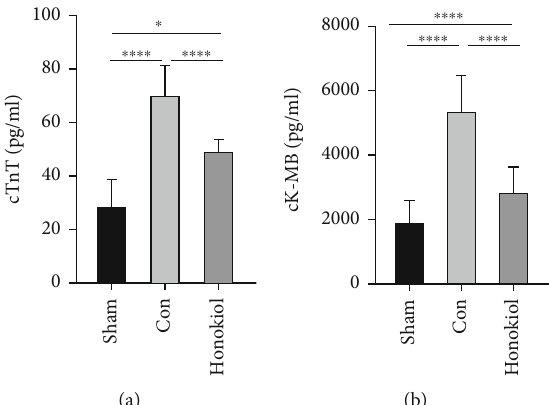
Figure 1: Plasma levels of myocardial injury markers. Expression levels of (a) cTnT and (b) CK-MB. Sham: sham operation; Con: MI/RI with the vehicle; Honokiol: MI/RI with Honokiol. N = 10 for each cohort. Data are articulated as mean ± SEM . ∗ p < 0 : 05 ; ∗∗∗ ∗ p < 0 : 0001 .